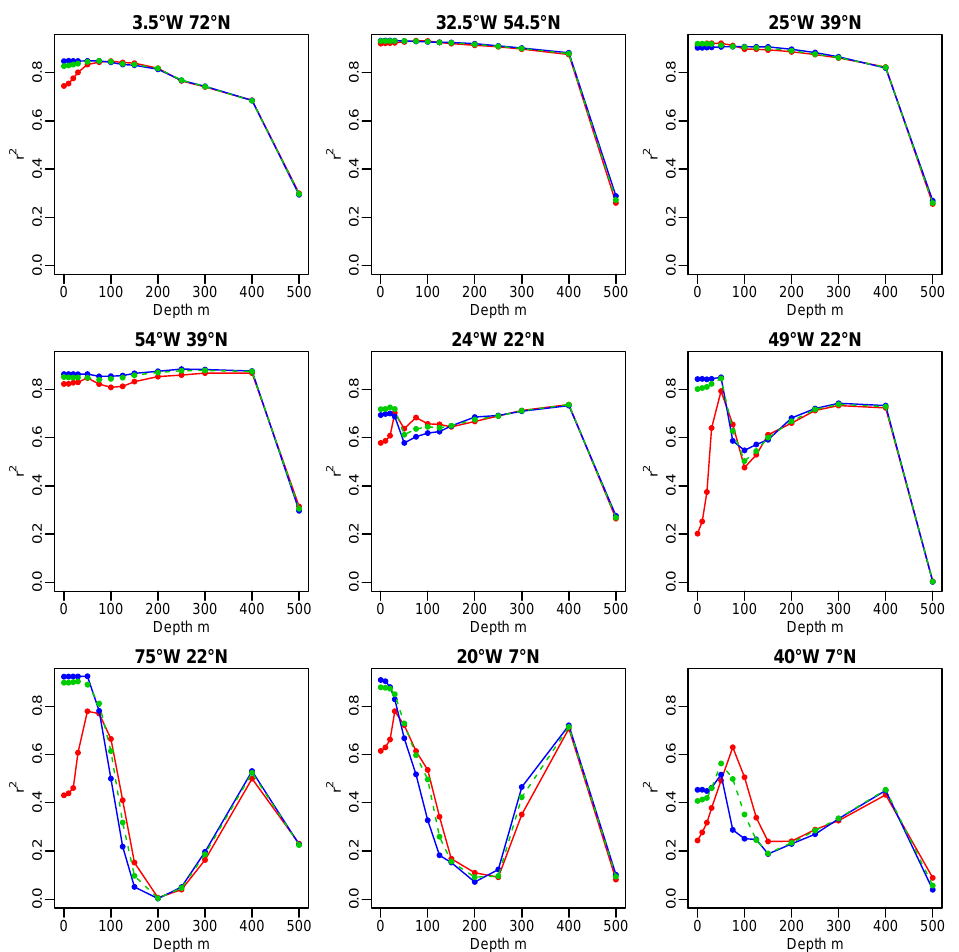
Fig. 3. Transfer function performance, shown as the r 2 between measured and predicted temperatures for different depths and seasons, for sites in different 1400km radius regions (see Fig. 1) of the North Atlantic calibration set. Legend as Fig. 2.